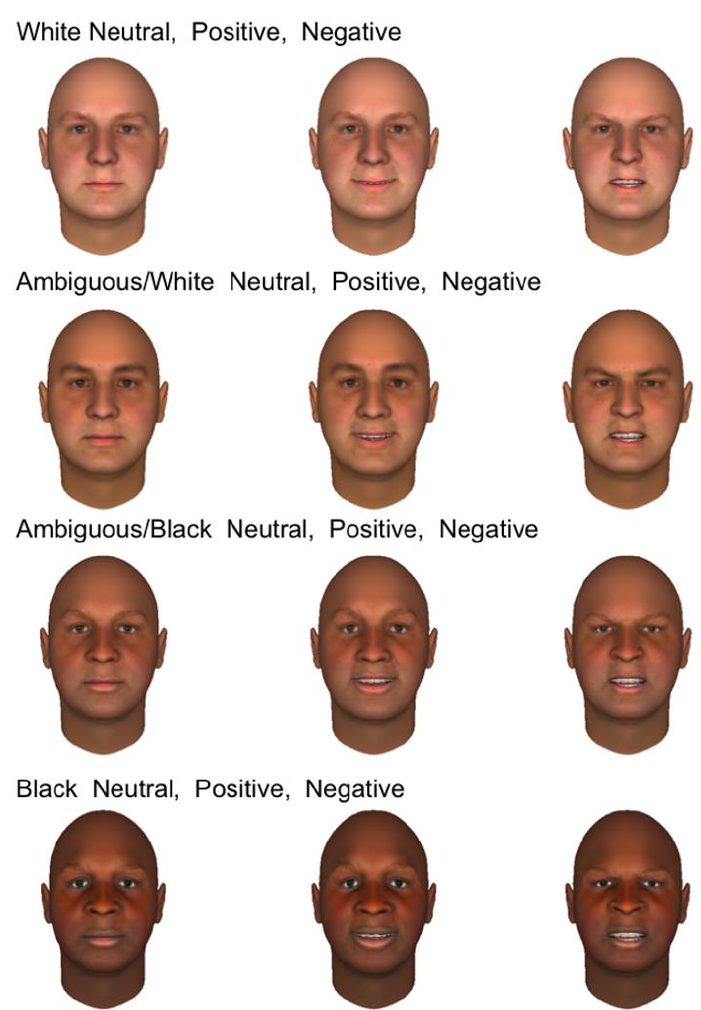
Figure 1. An example set of 12 FaceGen faces created from an original photograph. From left to right, columns show faces with neutral, positive, and negative expressions. With affect parameters frozen, faces were morphed along the race dimension, which involved simultaneous changes in both skin tone and facial morphology. From top to bottom, faces ranged from White to Black, with intermediate ambiguous versions.